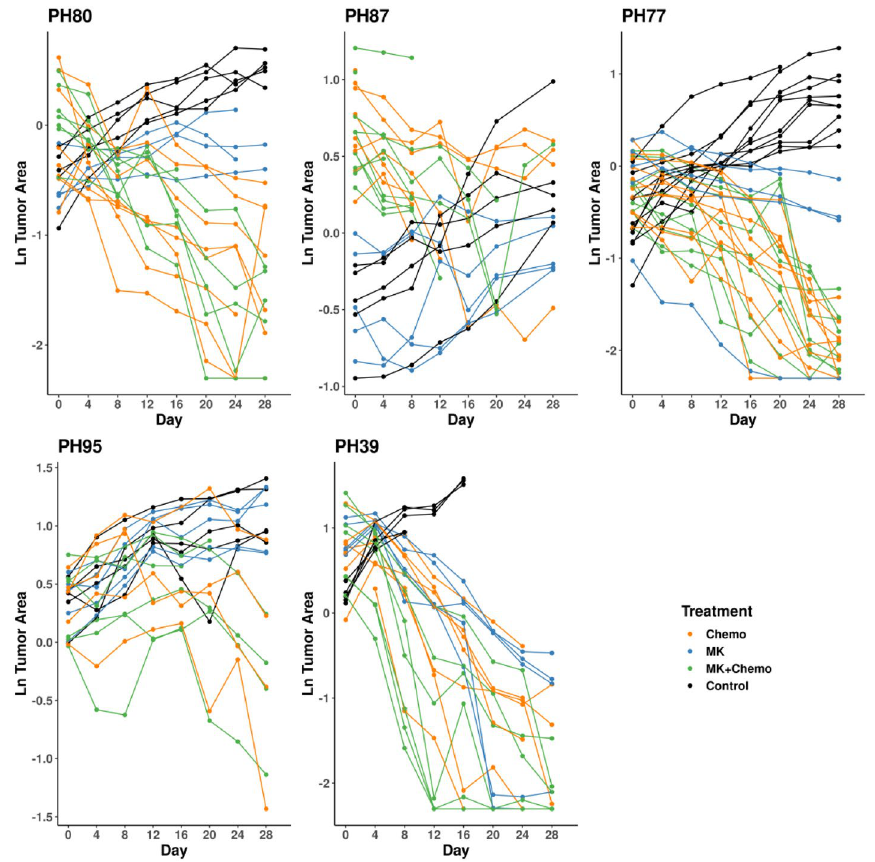
Figure 1. Profile plots on the natural log scale. Profile plot (per-mouse intraperitoneal tumor area trajectories measured via ultrasound) for all five Case Study PDX models on the natural log scale used for modeling. Coloring indicates drug arm: control (diluent), chemo (carboplatin + paclitaxel), the PARPi niraparib (MK), or chemo + MK (carboplatin + paclitaxel + MK). Lines connect observations from the same mouse provide a visual check of balance at baseline (day = 0), a sense of whether growth trajectories are straight or curved (functional form), and the magnitude of between mouse variation and attrition. Per arm sample sizes at day 0 for each PDX model are as follows: PH80: control n = 5, chemo n = 8, MK n = 5, MK + chemo n = 7; PH87: control n = 5, chemo n = 9, MK n = 5, MK + chemo n = 7; PH77: control n = 10, chemo n = 10, MK n = 5, MK + chemo n = 9; PH95: control n = 5, chemo n = 6, MK n = 5, MK + chemo n = 6; PH39: control n = 5, chemo n = 8, MK n = 5, MK + chemo n =